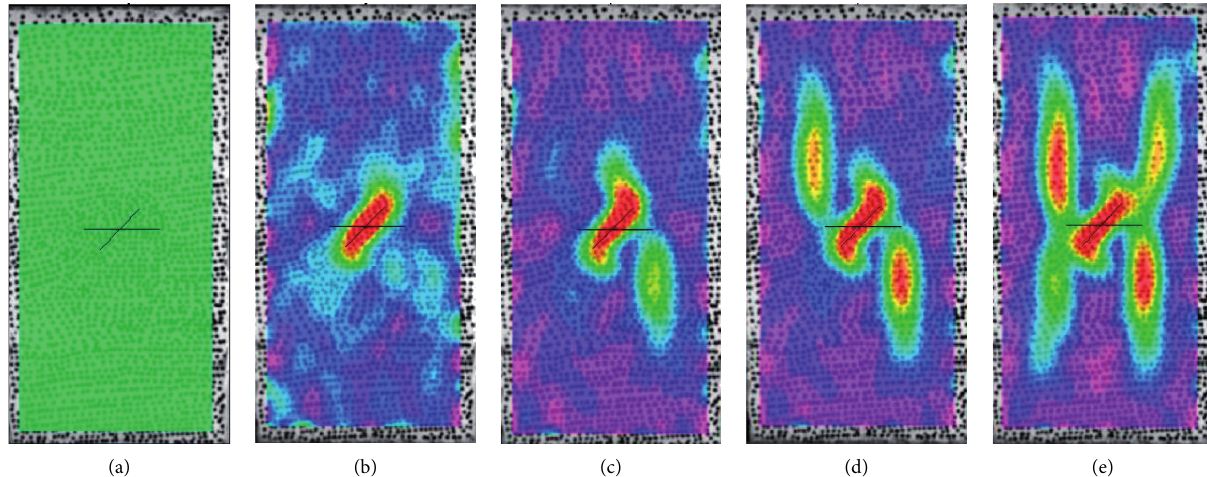
Figure 12: Stress field developed at different times for the jointed specimen with α � 45 ° . (a) t � 0s. (b) t � 500s. (c) t � 660s. (d) t � 890s. (e) t �